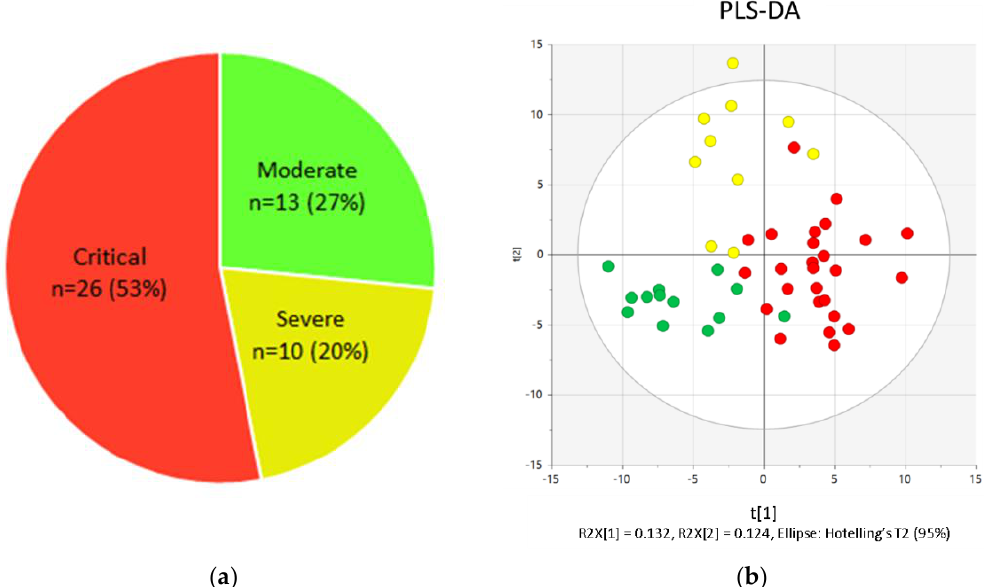
Figure 1. ( a ) Distribution of hospitalized COVID-19 patients stratified according to severity; ( b ) supervised partial least squares discriminant analysis (PLS-DA) showing the discrimination between COVID-19 patients regarding severity.